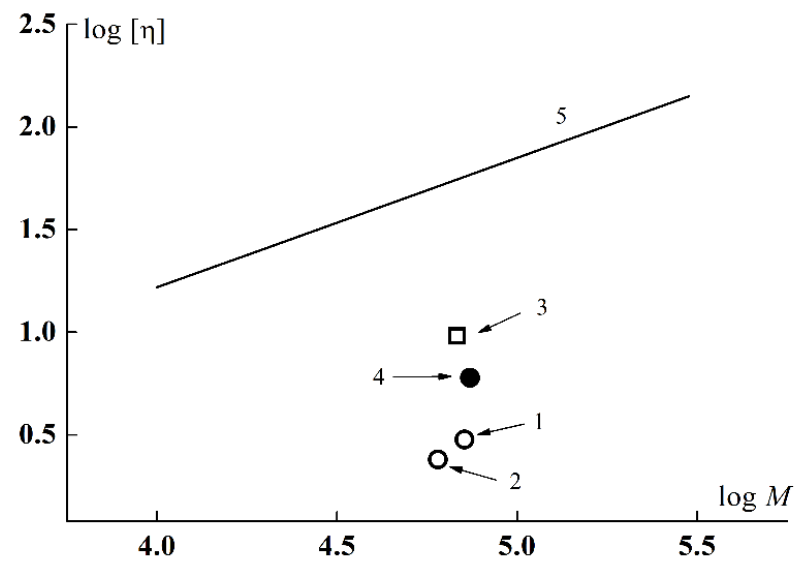
Figure 5. Intrinsic viscosity [ η ] vs. M w for APE O -g-PiPrOx sample 1 (1) and sample 2 (2) in nitro- propane, APE O -g-PiPrOx sample 3 in DMF (3), APE 8 -g-PiPrOx [62] (4), and Mark–Kuhn–Houwink– Sakurada dependence [ η ] = 5.0 × 10 − 2 M 0.63 given for linear PEtOx [75] (5). Based on the experimentally measured values of M w for APE O ( M APE ) and the copoly- mers, as well as the mass of the side chain M s , the architecture parameters of the APE O -g- PiPrOx graft copolymer were calculated, which are given in Table 2. The side chain length in the extended conformation without deformation of bond angles was calculated using the formula L s = λ × N s , since the length of the projection of the alkylene unit onto the direction of the PiPrOx chain is λ = 0.252 nm. Accordingly, molar masses M s of side chains are equal to M s = N s × M 0s , where the mass of the PiPrOx monomer unit, M 0s = 113 g/mol. Then the degree of functionalization of the macroinitiator (or grafting density of side chains) is z = m/(n + m ) = m / N 0 , where m is the number of the backbone monomer units containing side chains (i.e., the number of side chains) and n is the number of the monomer units of the macroinitiator which do not contain side chains [59,60]; m was cal- culated using the formula m = ( M w − M APE )/ M s . Table 2. Structural parameters for APE O -g-PiPrOx. Copolymer M w , g/mol M s L s , nm δ 1